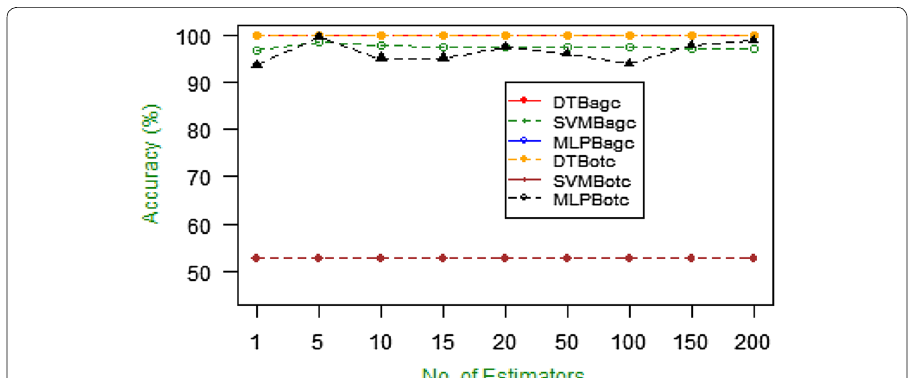
Fig. 8 Bagging and boosting classifiers accuracy over the NYSE dataset